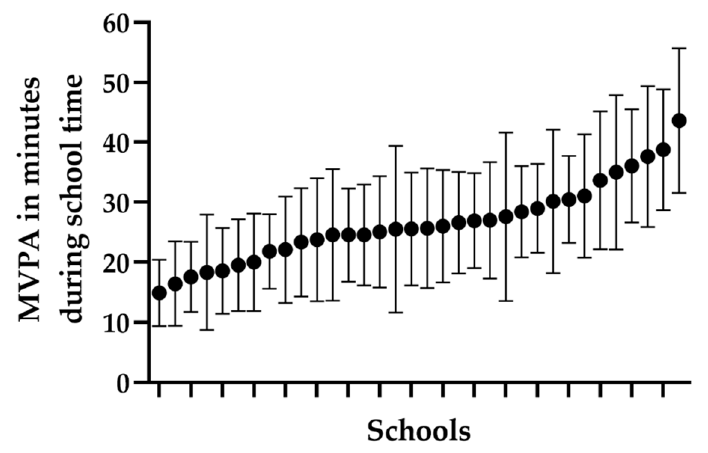
Figure 3. Variation in the participants’ moderate-to-vigorous physical activity (MVPA) during school time across schools in ranked order, presented as means with standard deviation. Schools are ordered after time spent in MVPA.